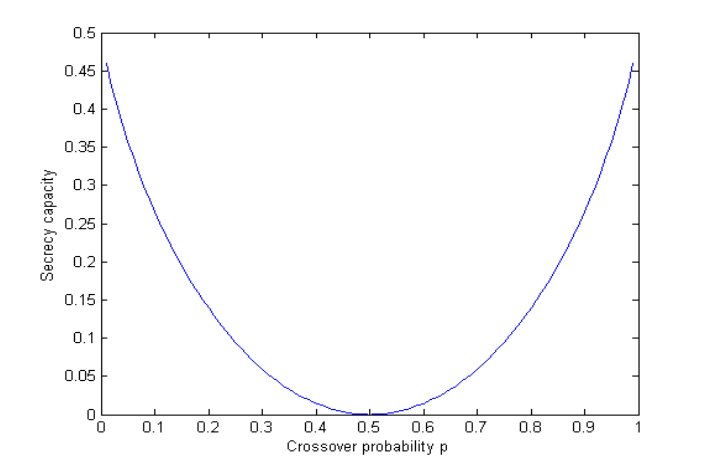
Figure 4. Secrecy capacity of the two-state Markov erasure wiretap channel in Example